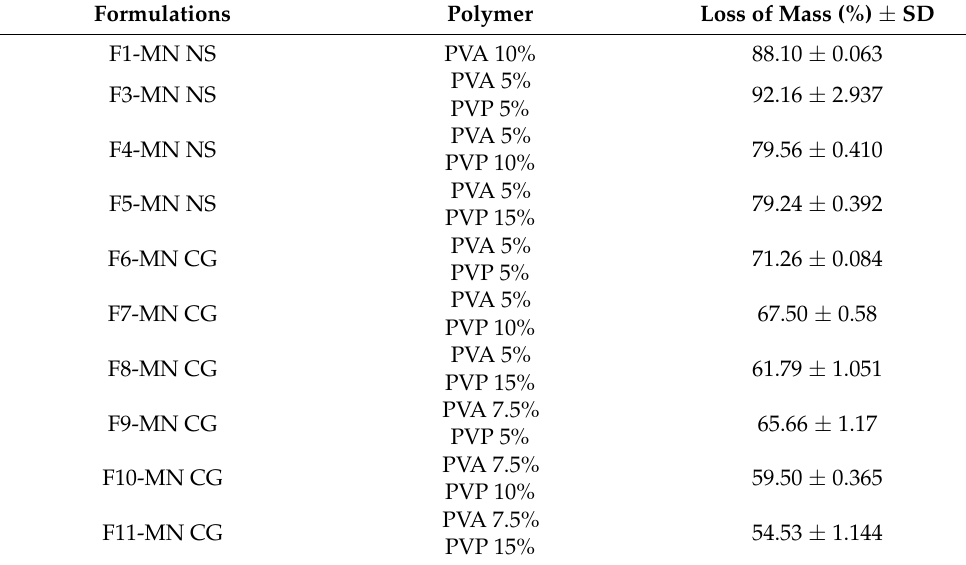
Table 7. Loss of Mass of DMN Containing Nanosuspension and Co-grinded Ketoprofen (n = 3, mean ±